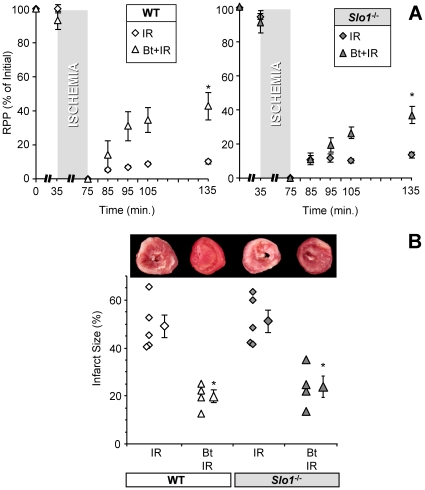
Cardioprotection by the BK activator bithionol.Perfused hearts were subjected to IR injury (from Figure 2) or Bithionol (Bt)+IR in WT (white symbols) and Slo1-/- (gray symbols) FVB littermate mice, as outlined in Supporting Information S1 methods. (A) Left-ventricular function (heart rate x pressure product, RPP) was monitored throughout, and is expressed as % of initial value. (B) Upon completion of IR protocols, hearts were sliced, fixed and stained with TTC, to delineate live (red) and infarcted (white) tissue. Upper panel shows typical slices used for quantitation of infarct area. Lower panel shows infarct expressed as a percent of the area at risk (100% in this global ischemia model). All data are means ± SEM, N≥4 (N = independent hearts). *p<0.05 vs. IR.